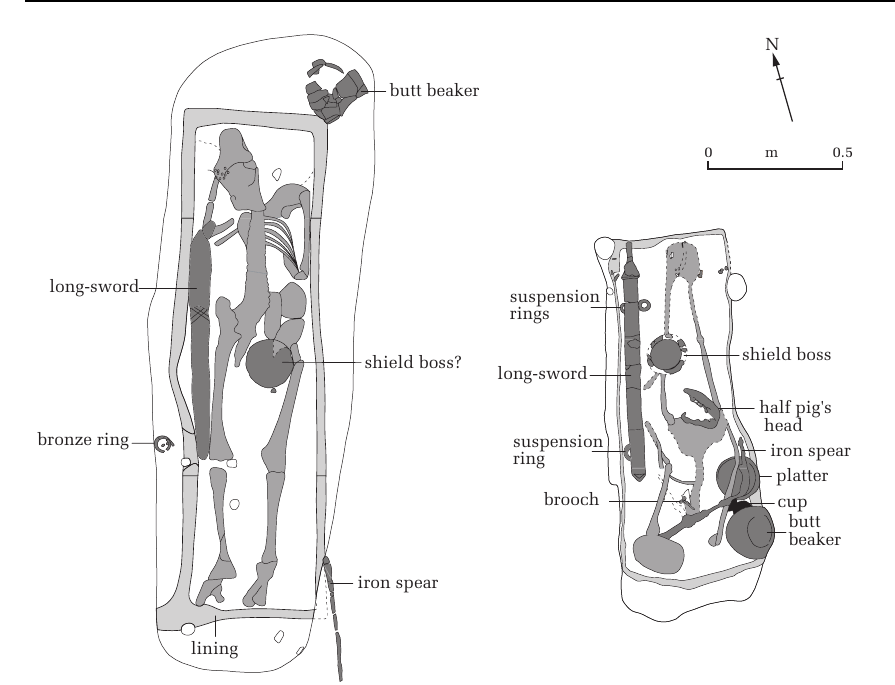
Figure 4 Warrior burial B19, prior to the lifting of the grave goods; the butt beaker, bent iron spear, shield boss and long- sword are clearly visible (horizontal scale bar 40cm).